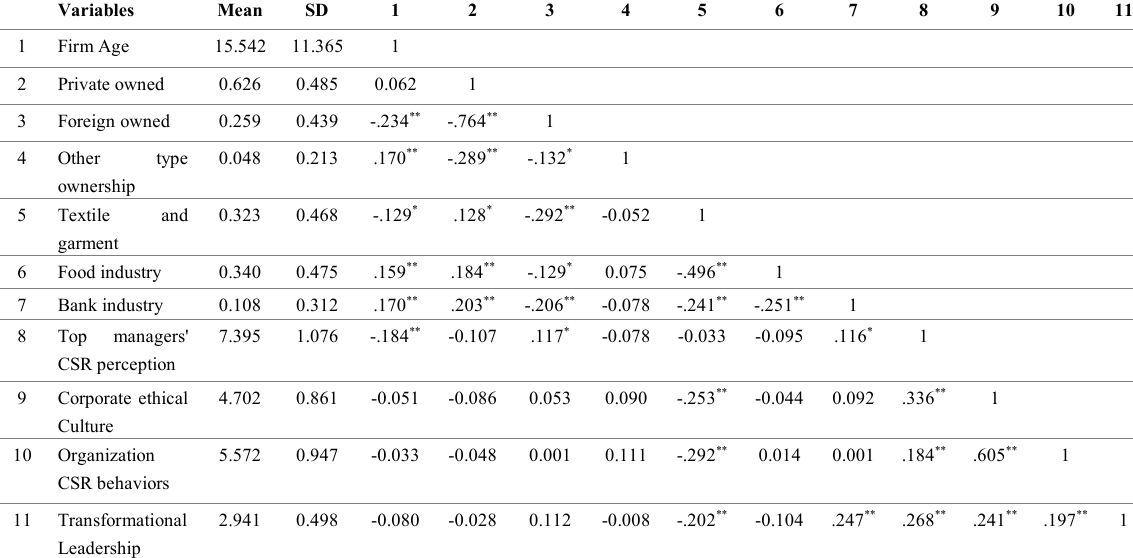
Table 1: Descriptive and correlation statistics